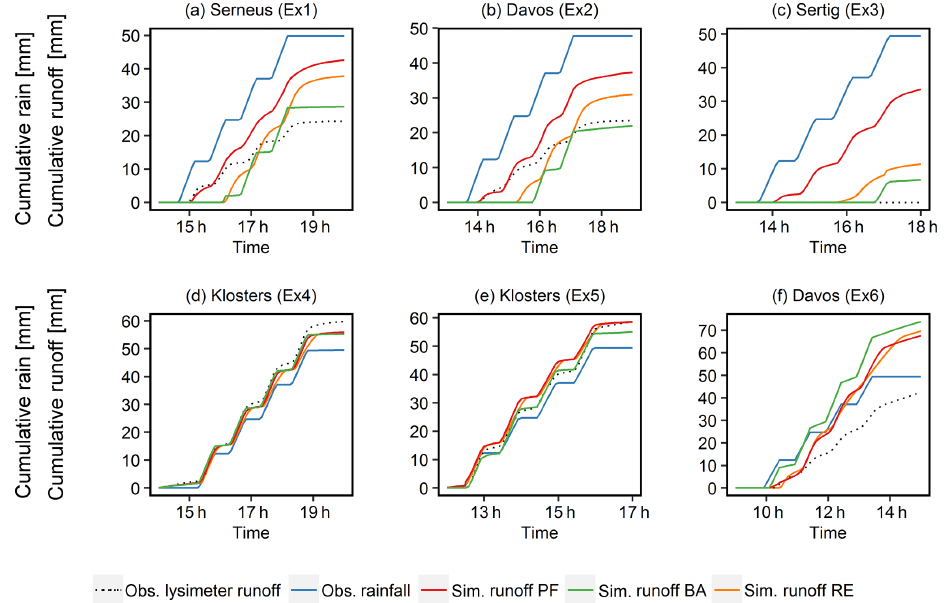
Figure 4. Cumulative rain and snowpack runoff displayed for the six sprinkling events. Ex1 (a) –Ex3 (c) were conducted during winter conditions, Ex4 (d) –Ex6 (f) were conducted during spring conditions.